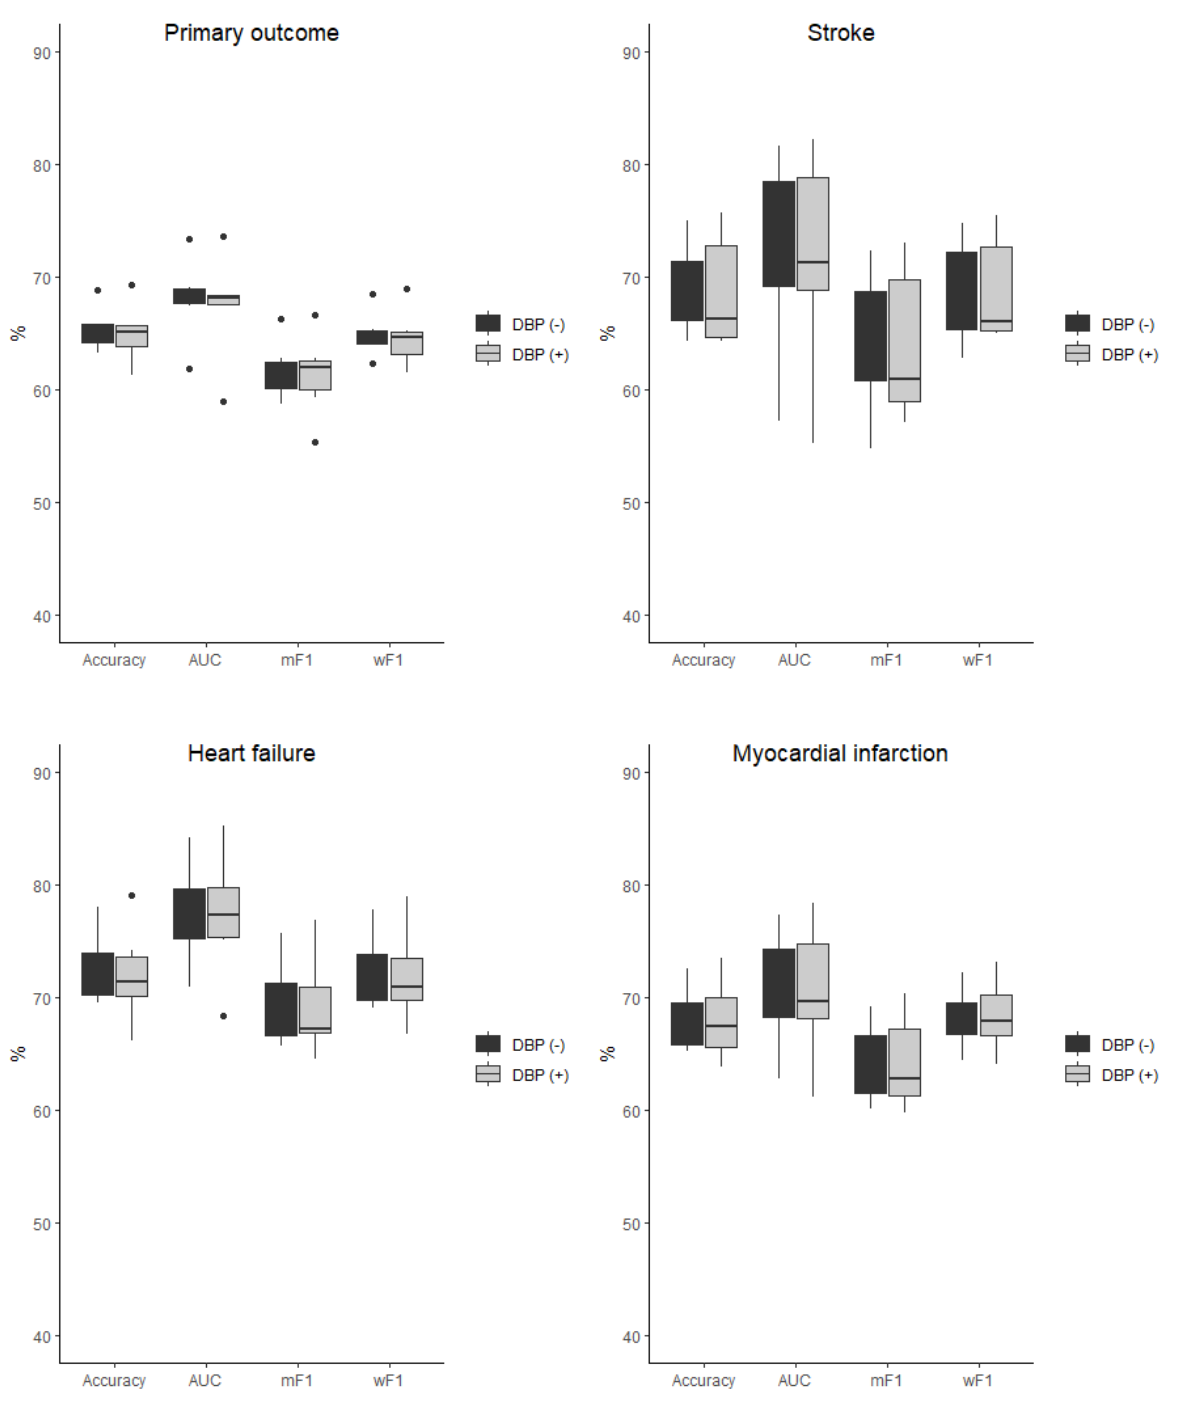
Figure 2. Comparison of the performance of the classifiers when DBP was included (DBP (+)) and excluded (DBP ( − )) as the predictor presented as boxplots for all outcome variables examined in the unselected population. AUC—area under curve, mF1—mean F-measure, wF1—mean weighted F-measure, no differences detected for all of the comparisons.